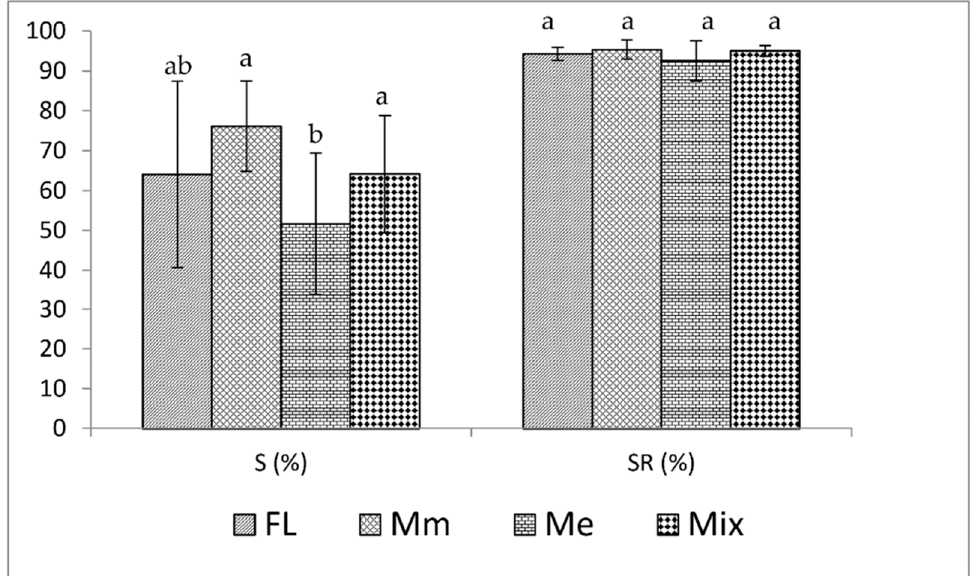
Figure 1. Survival (S) and stress resistance (S R ) of dorada Brycon sinuensis larvae fed different live prey. Different letters indicate a significant difference ( p < 0.05). Forage larvae of Piaractus brachypomus (F L ); Moina minuta (Mm); Macrothrix elegans (Me); mixture (50:50) of the Moina minuta and Macrothrix elegans (Mix).